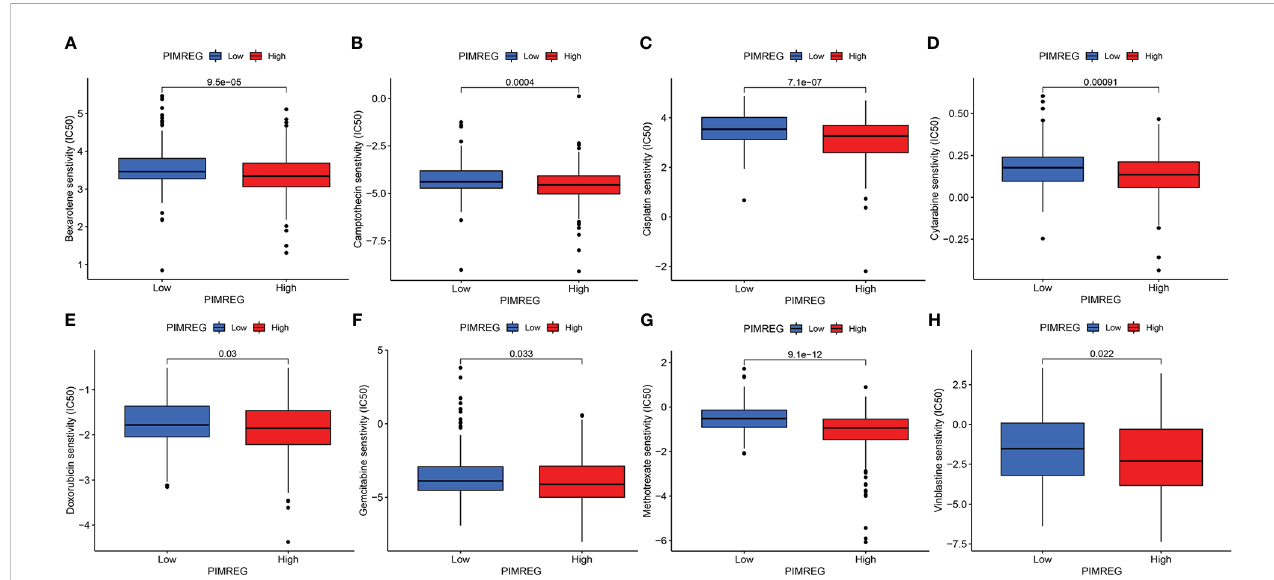
FIGURE 8 The sensitivity of patients in high PIMREG expression group and low expression group to different drugs. (A) bexarotene, (B) camptothecin, (C) cisplatin, (D) cytarabine, (E) doxorubicin, (F) gemcitabine, (G) methotrexate, (H)